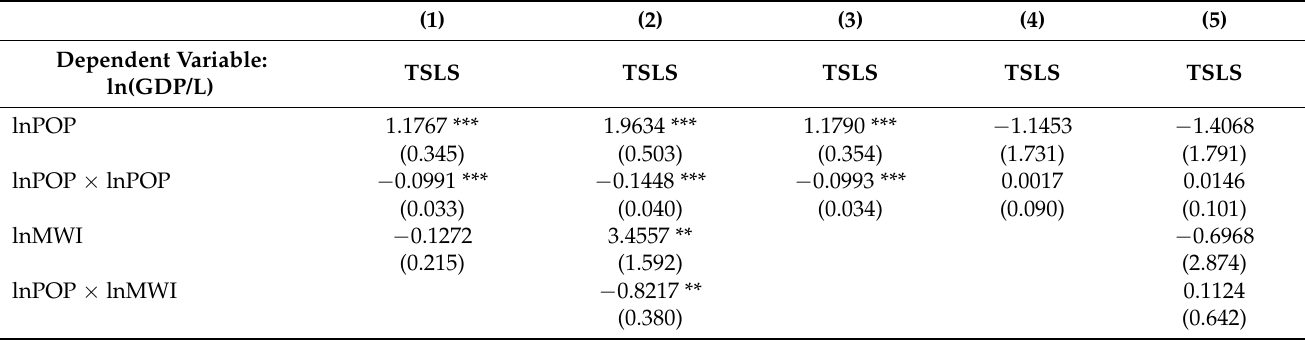
Table 5. TSLS regression